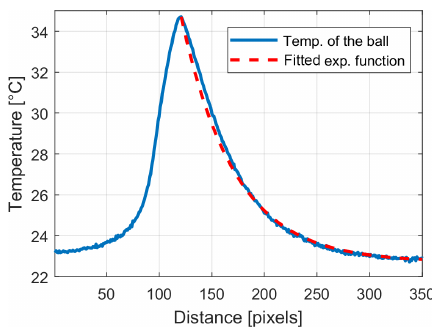
Figure 13. Blurred temperature profile from Fig. 5a and the fitted exponential function.